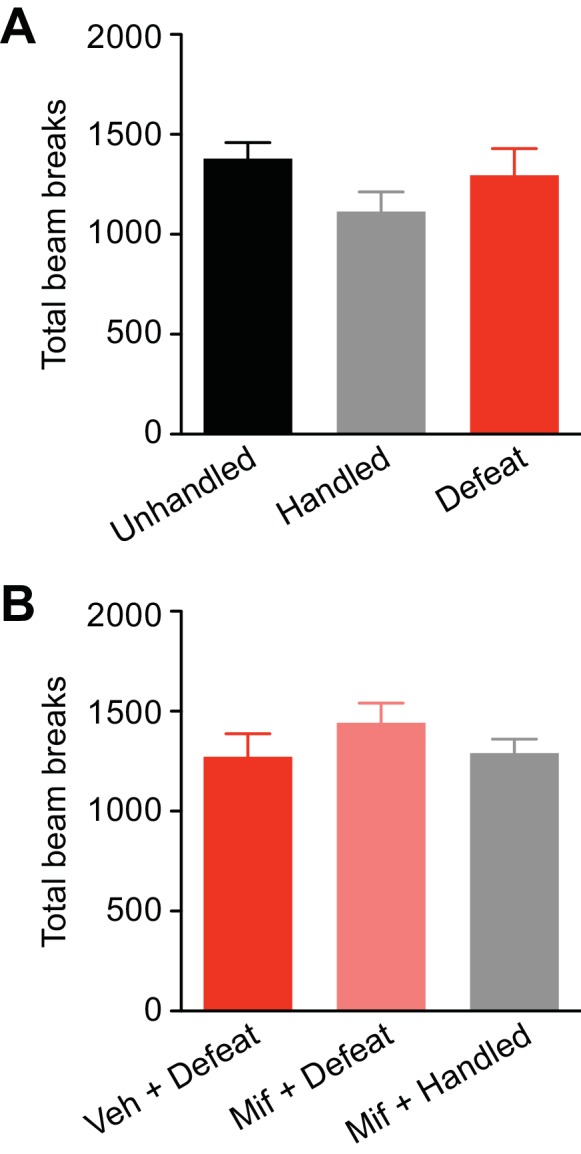
Summary graphs depicting the overall activity level (i.e., total number of beam breaks in the CPP box compartments) during the pretest for the experiments shown in Figure 7.(A) Data from the groups in Figures 7A and B (F2,20 = 1.76, p=0.20, one-way ANOVA). (B) Data from the groups in Figure 7C and D (F2,23 = 0.92, p=0.41, one-way ANOVA).